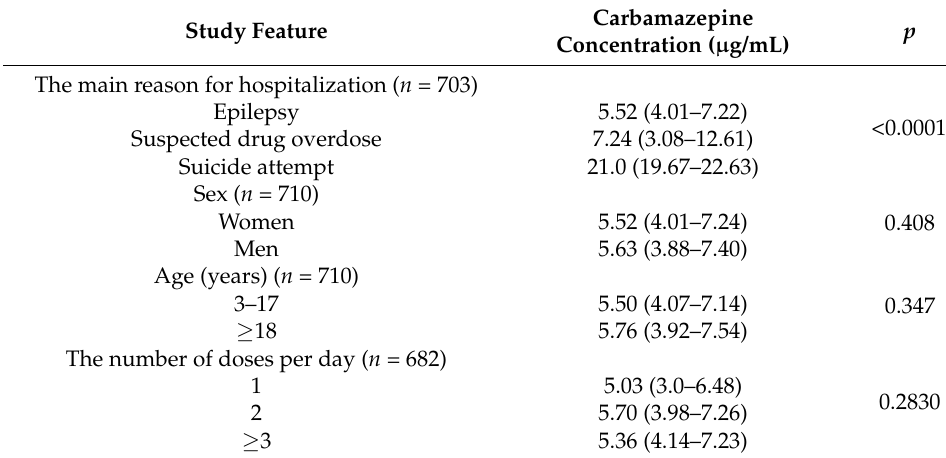
Table 2. Carbamazepine concentration in the study population depending on selected clinical parameters (median (lower quartile–upper quartile) or number